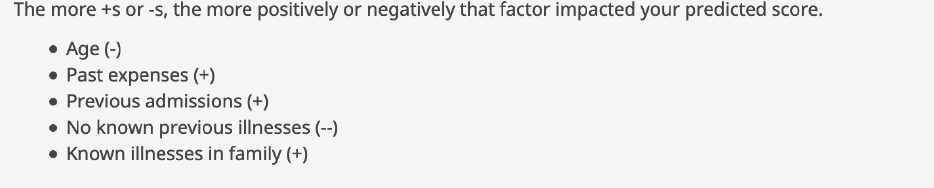
Figure 2. An example of the